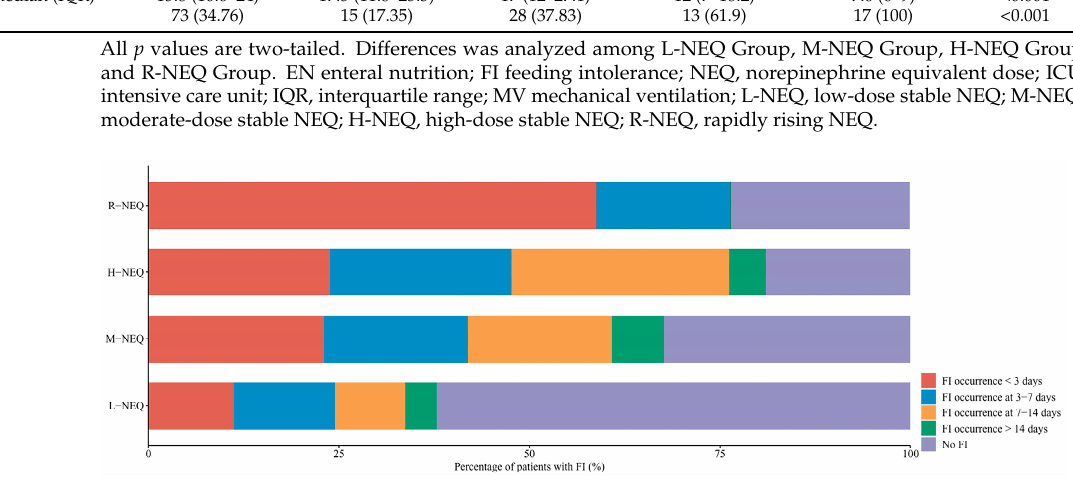
Figure 4. Stack graph of the percentage of patients with FI at different days in each group. FI, feeding intolerance; L-NEQ, low-dose stable NEQ; M-NEQ, moderate-dose stable NEQ; H-NEQ, high-dose stable NEQ; R-NEQ, rapidly rising NEQ.